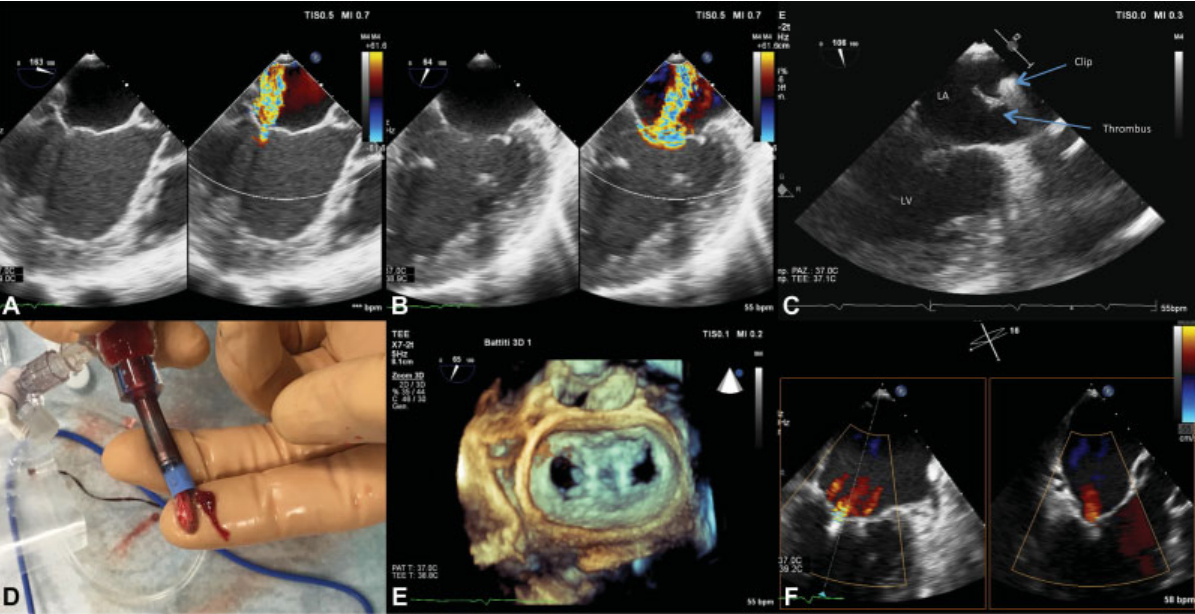
Fig. 1 Intraprocedural echocardiography and clip thrombosis. ( A ) Intraprocedural transesophageal echocardiography (TEE) color Doppler at the left ventricular out fl ow tract view showing severe mitral regurgitation (MR). ( B ) TEE at the intercommissural view showing the extension of severe MR to the entiremitralvalveori fi ce.( C )Thrombusadherent totheclipduringthemaneuverstoorient thesecondcliptowardthemitralori fi ce.LA,leftatrium;LV,left ventricle. ( D ) Picture of the clip and the thrombus once retrieved from the patient. ( E ) Double ori fi ce of the mitral valve at 3D echocardiography after implantation of the two clips. ( F ) Final procedural result with residual trivial mitral regurgitation, X-plane